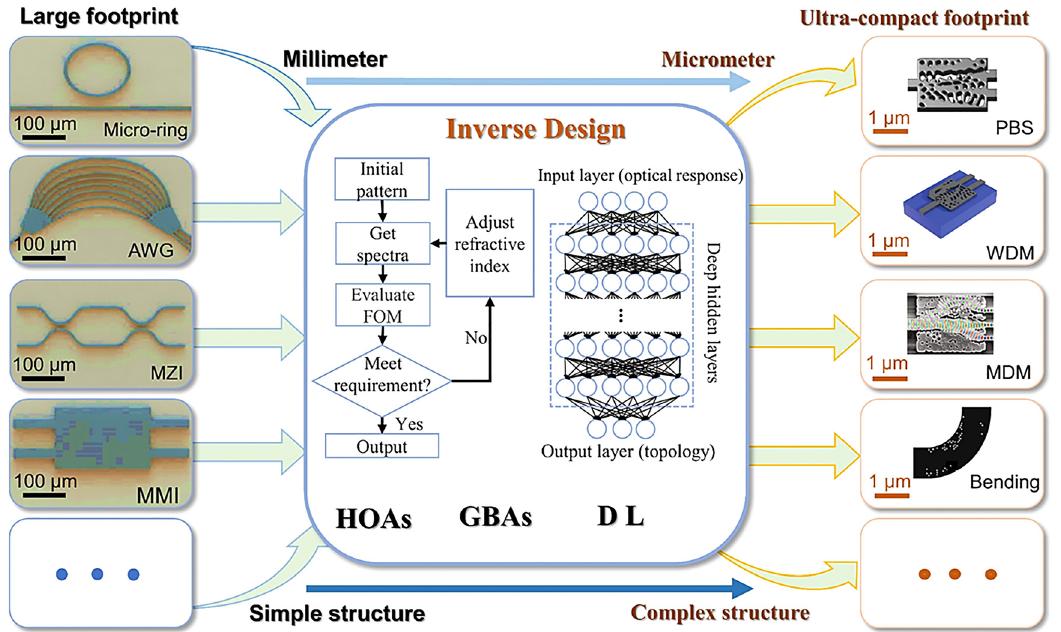
Figure 1: A schematic diagram depicting the methods of computational inverse design and the comparisons between traditional nanophotonic devices and inverse-designed nanophotonic devices. Left: Traditional devices with large footprints and simple structures, including the Micro-ring, Mach-Zehnder interferometer (MZI), Multimode interference (MMI) coupler and so on. Middle: The optimization processes of computational inverse design and three kinds of associated optimizationalgorithms,includingheuristicoptimizationalgorithms(HOAs),gradient-basedalgorithms(GBAs)anddeeplearning(DL).Right: inverse-designed nanophotonic devices with ultra-compact footprints and complex structures, including polarization beam splitter (PBS) (Reproduced with permission [16]. Copyright 2013, Optical Society of America), wavelength-division multiplexing (WDM) (Reproduced